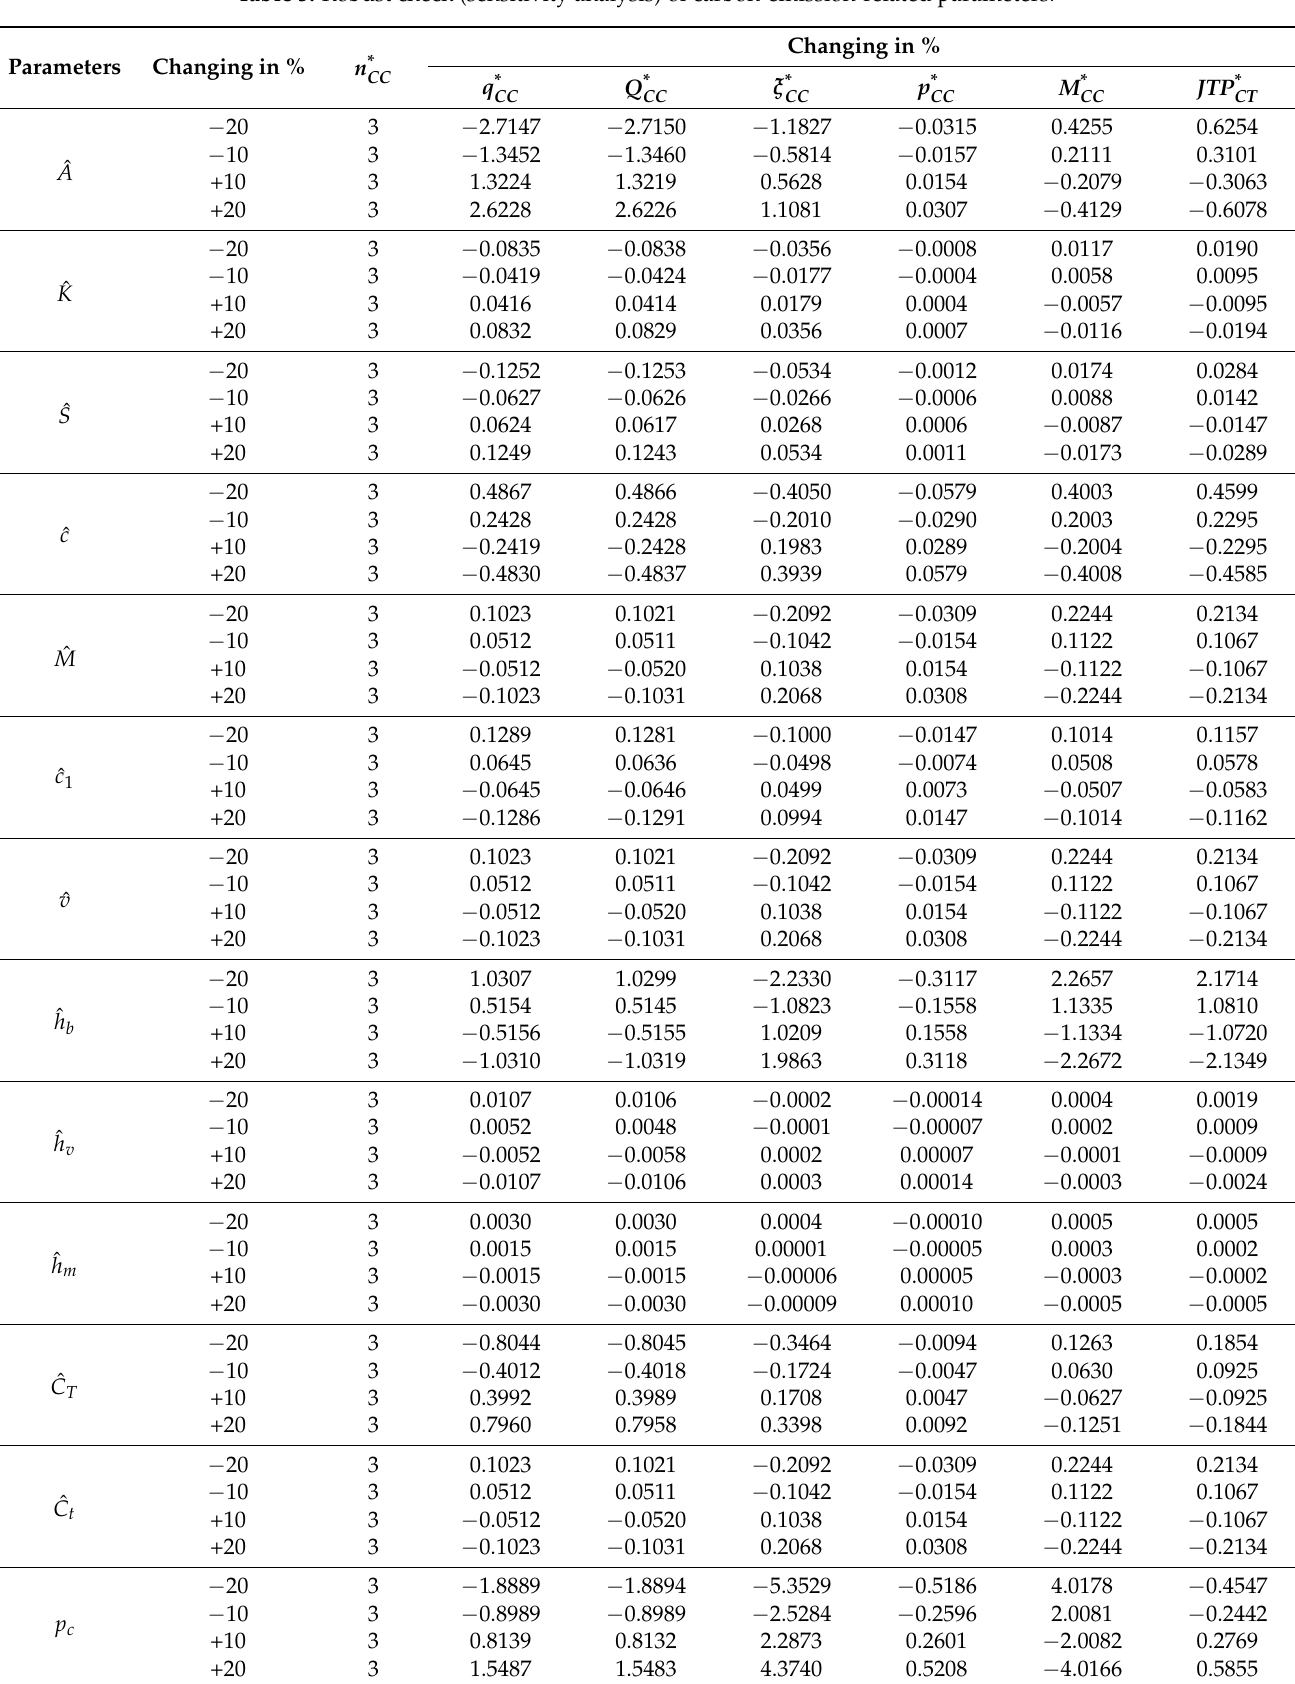
Table 3. Robust check (sensitivity analysis) of carbon-emission-related